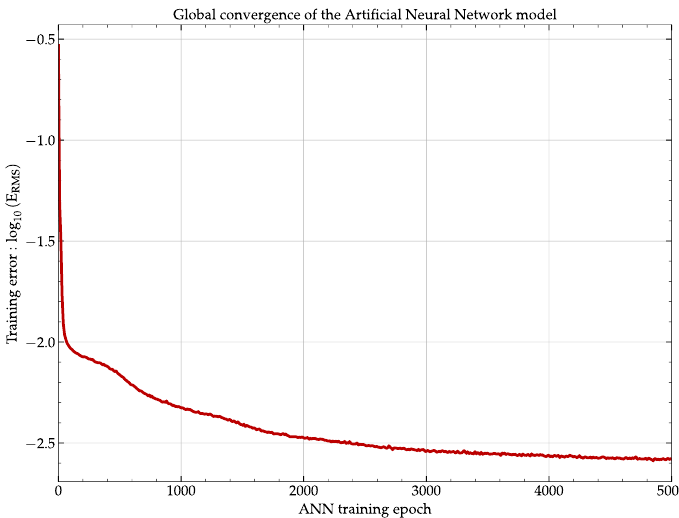
Figure 12. Convergence of the ANN model during the training